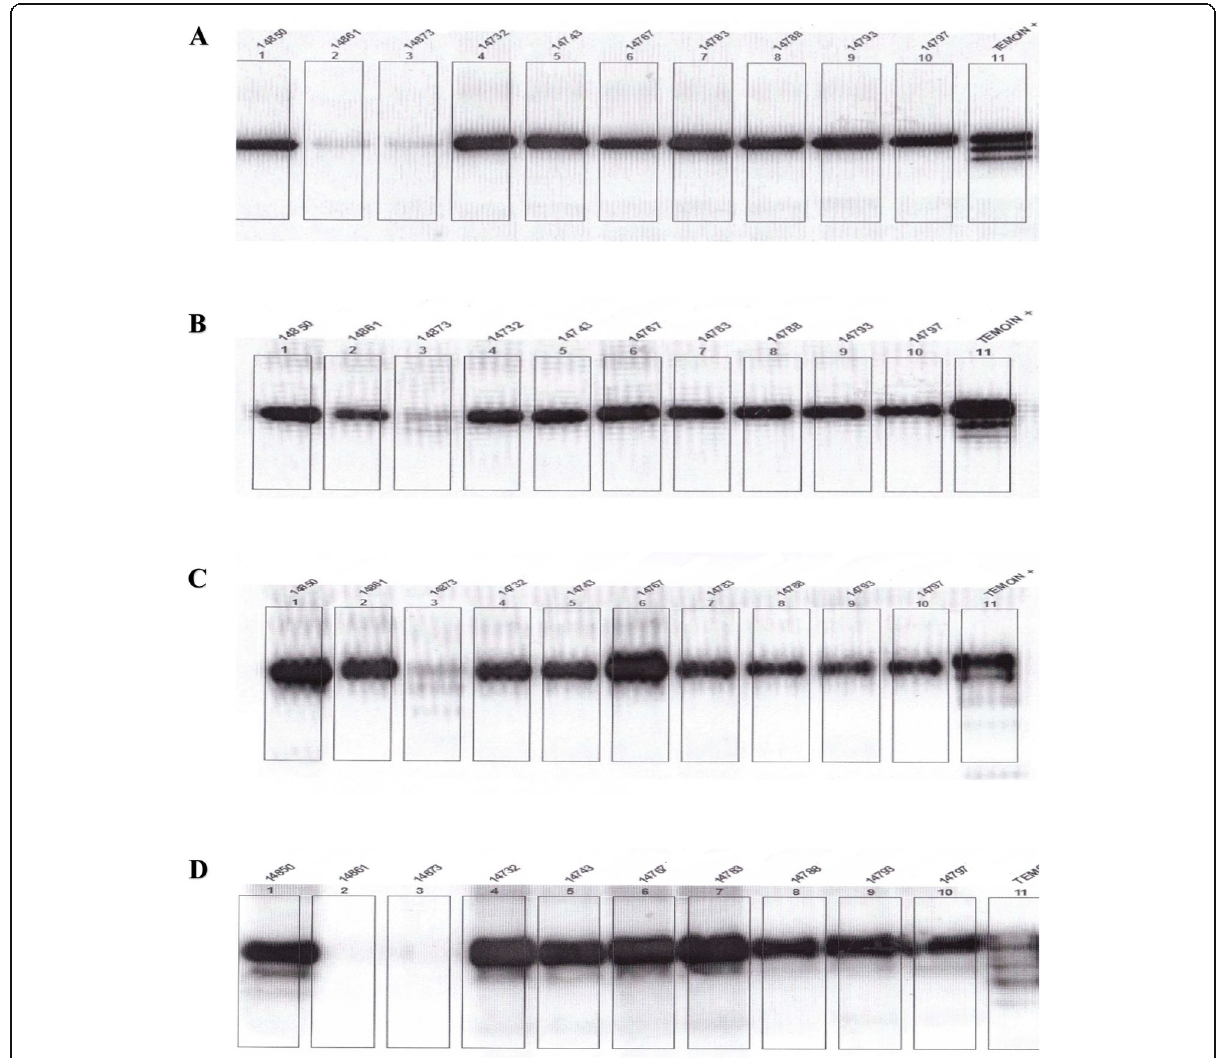
Fig. 3 Separation of a transferrin, b α -1-antitrypsin, c α -1-acid glycoprotein and d hepatoglobin of 10 controls using WB technique